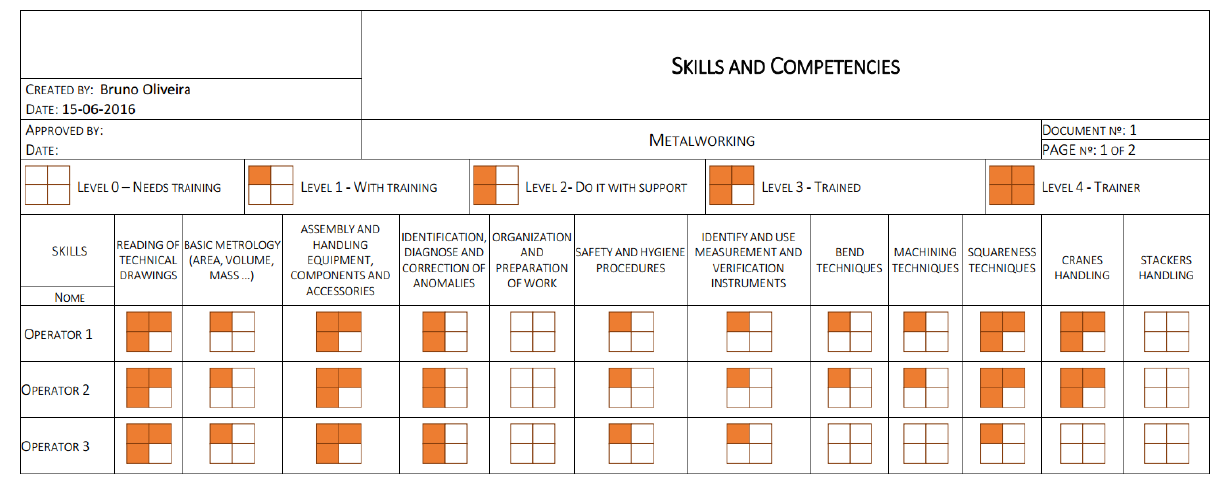
Figure 8. Skills matrix extract.